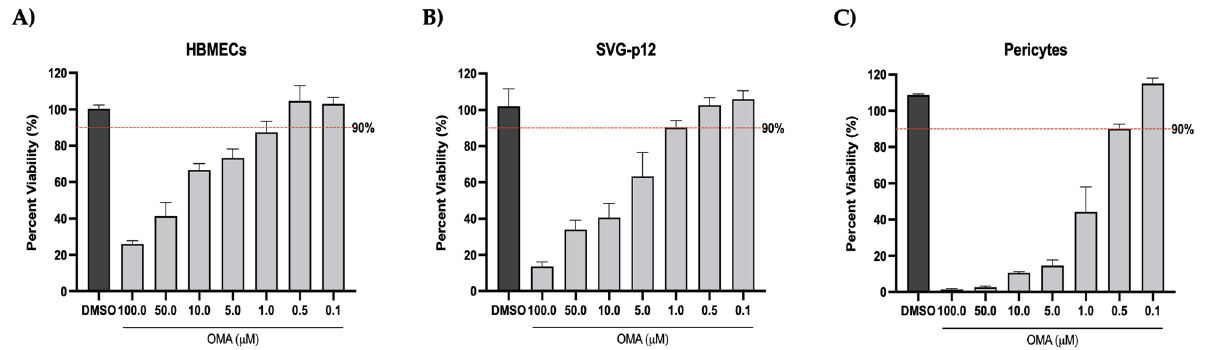
Figure 2. Cell viability assessments of the cellular components of the gNVU following OMA treatment. HBMECs ( A ), SVG-p12 astrocytes ( B ) or pericytes ( C ) were seeded in 96-well plates and allowed to reach confluency overnight. Culture medium with OMA included at increasing concentrations was added to the cells and the cells were cultured at 37 °C for up to 24 h, after which cell survival was measured by CellTiterGlo assay. The % viability of the drug-treated cells is represented relative to the vehicle (DMSO) control. The 90% viability level is indicated by the broken red line. Data were obtained by averaging readings obtained from triplicate samples.